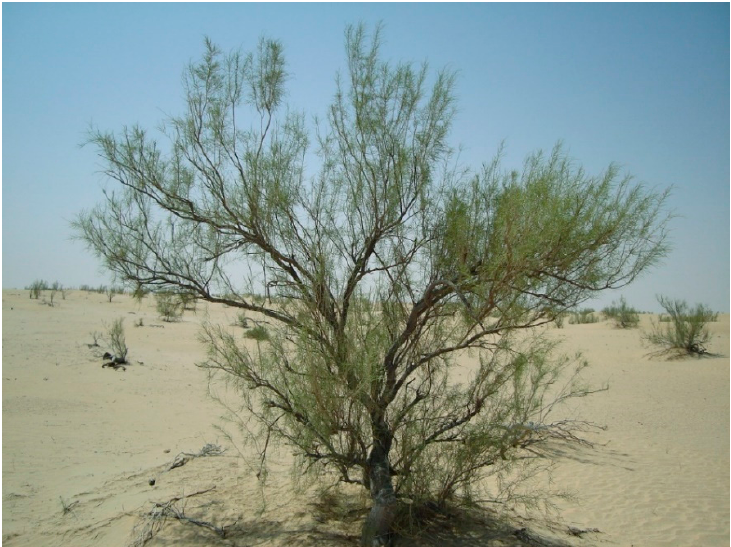
Figure 1. The H. persicum plant in its natural habitat, sand dunes.